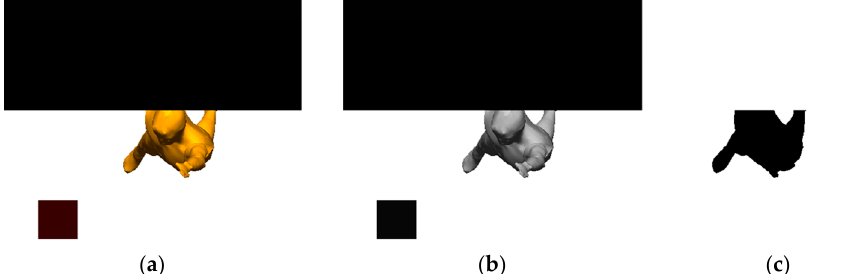
Figure 3. Process of calculating projected frontal area. ( a ) Screenshot image taken in front of the swimmer; ( b ) image of Figure 3a after grayscale processing; ( c ) image of Figure 3b after binary processing and threshold processing.